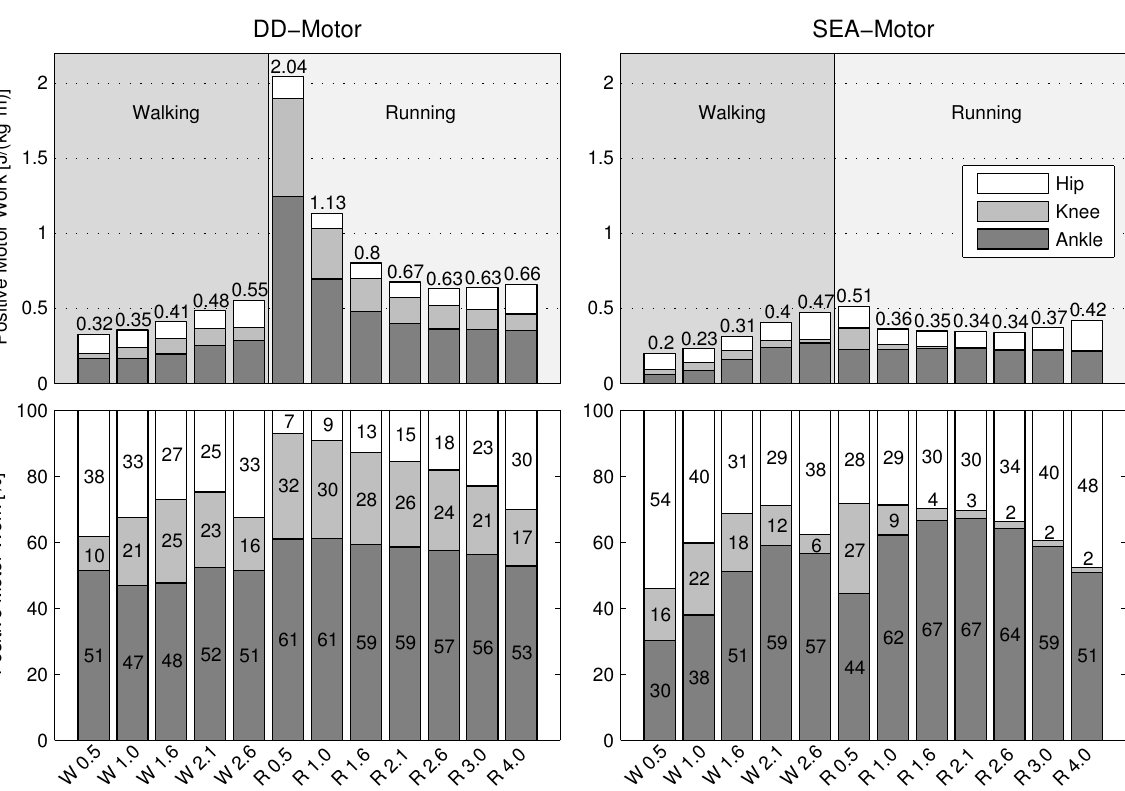
Figure 4. Absolute ( top ) and relative ( bottom ) positive motor work for a direct drive (DD, left )-driven leg (hip, knee and ankle) compared to a series elastic actuator (SEA, right )-driven leg for mimicking walking (W 0.5 m/s–W 2.6 m/s) and running (R 0.5 m/s–R 4.0 m/s). The preferred transition speed (PTS) where subjects typically change gait between walking and running was 2.1 m/s. Note that for some speeds, the total positive motor work does not add up to 100%, because relative motor work values were rounded to